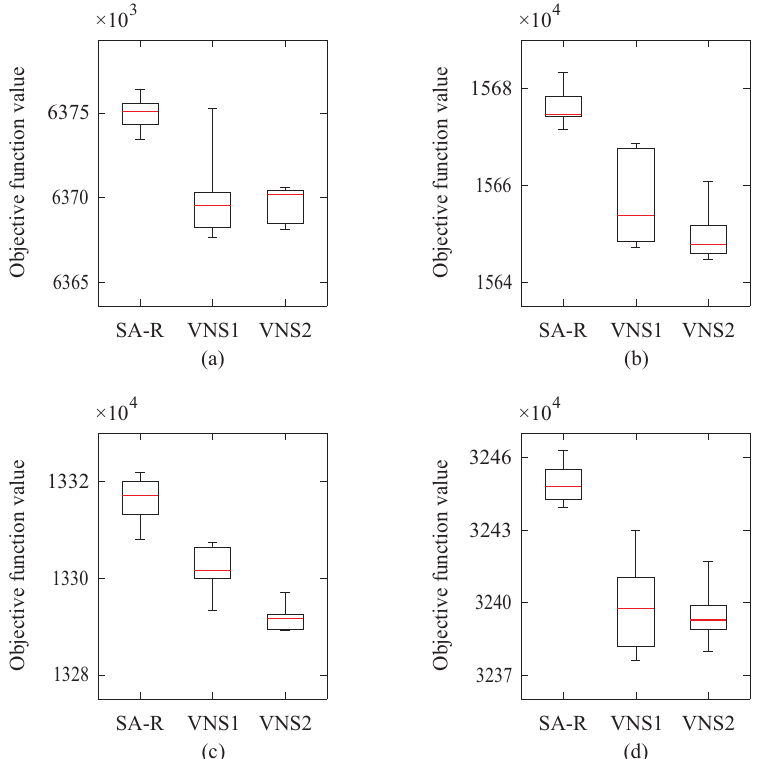
Figure 8. Objective function values achieved by SA-R, VNS1, and VNS2 on four DSRFLP instances with n (cid:54) 100: ( a ) p-70-3 ; ( b ) p-80-5 ; ( c ) p-90-3 ; and ( d ) p-100-5 .